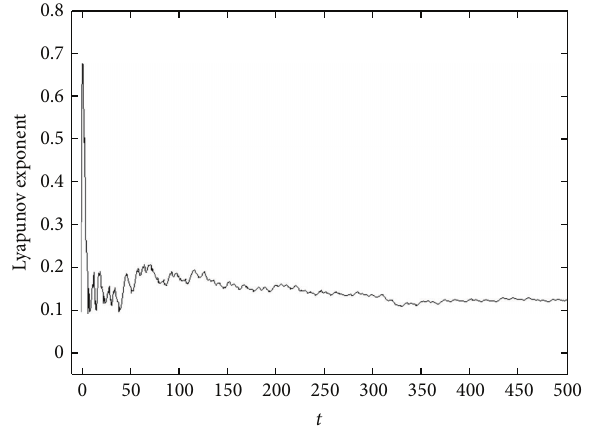
Figure 7: Lyapunov exponent diagram of (60) with 𝐹 = 2.90 .